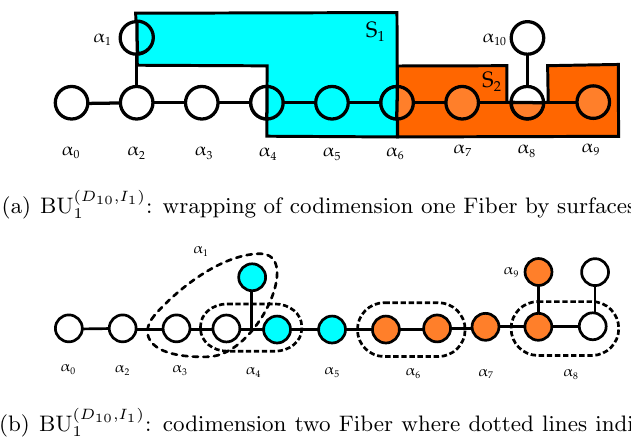
: codimension two Fiber where dotted lines indicate the splitting of the codimension one (cid:12)ber components. Figure 8 . Example blow-up BU ( D 10 ;I 1 ) . The (cid:12)rst row shows the wrapping of the codimension one 1 (cid:12)ber. The second row gives the full codimension two (cid:12)ber in terms of irreducible curves.